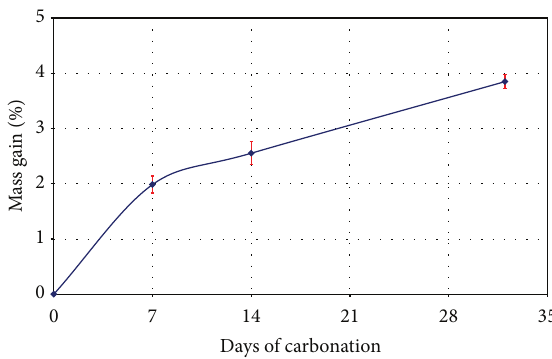
Figure 4: Mass gain during carbonation of cement mortar.